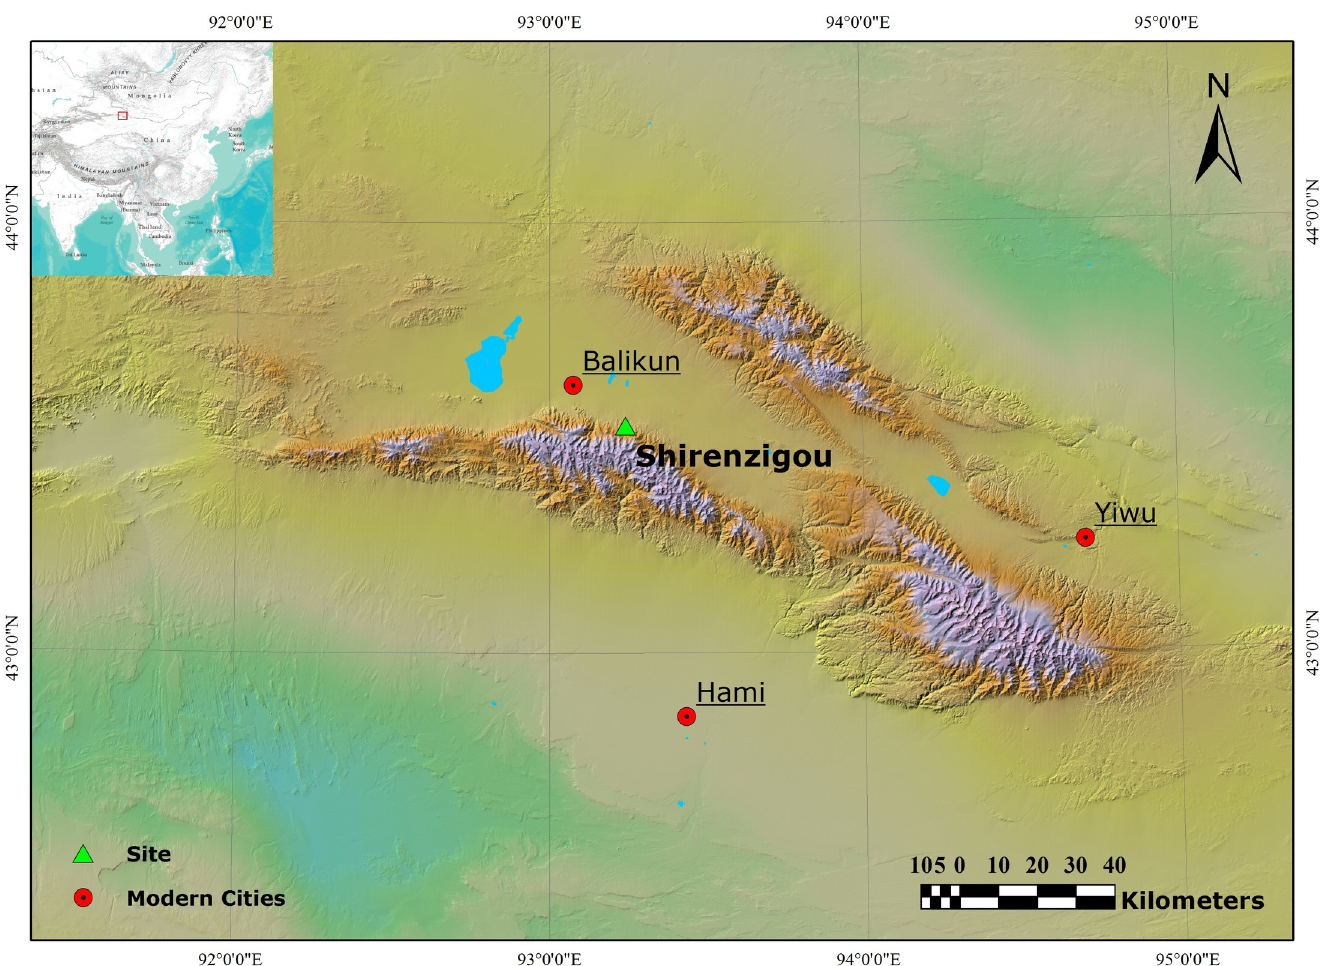
Fig 1. Map showing the location of Shirenzigou in the eastern Tianshan Mountain region, northwest China. Map produced in ArcMap 10.7.1. The digital elevation model was acquired from the Geospatial Data Cloud site, Computer Network Information Center, Chinese Academy of Sciences